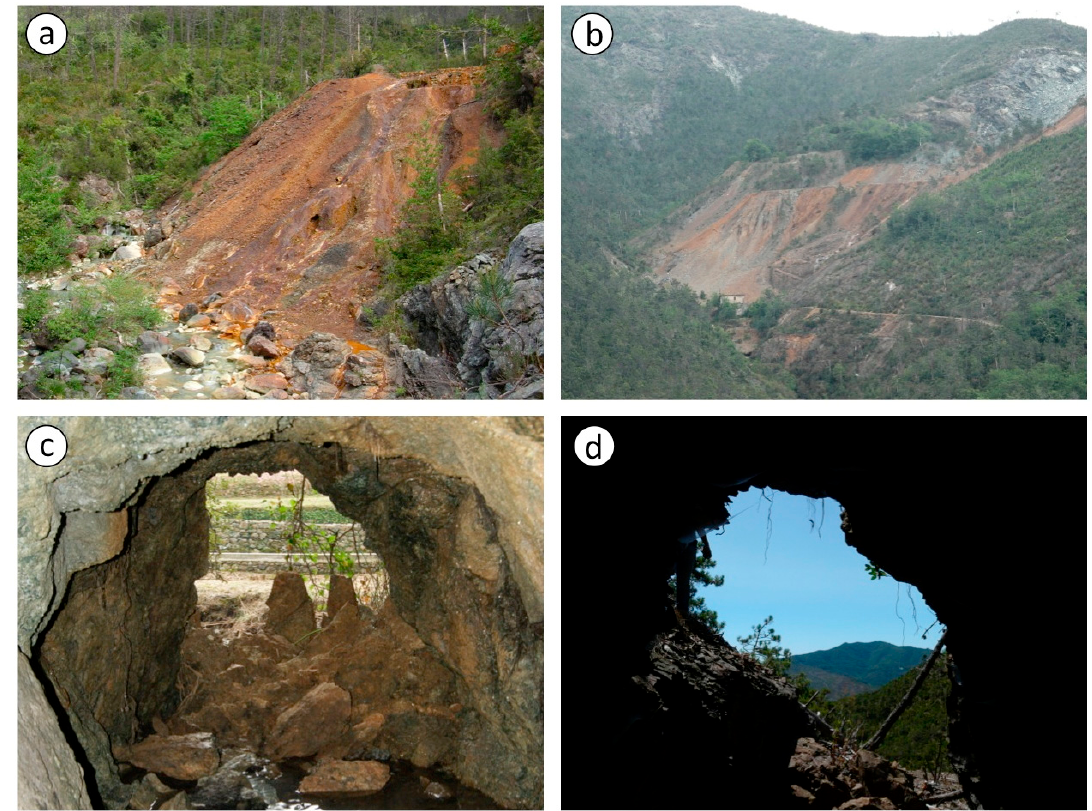
Figure 7. ( a ) Acid mine drainage flowing from a waste-rock dump to the Gromolo creek (Libiola mine); ( b ) huge open-air waste-rock dump at Libiola Mine with evidences of accelerated erosion processes and local landslides; ( c ) easily accessible mine adit at Monte Loreto Mine with signs of collapse in the tunnel roof; ( d ) easily accessible mine adit at Gallinaria Mine.